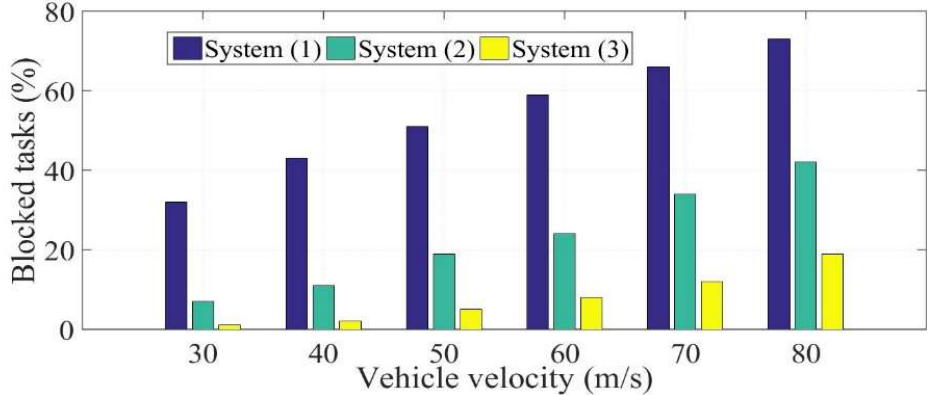
Figure 9. Percentage of blocked tasks for the three systems at different vehicle velocities.